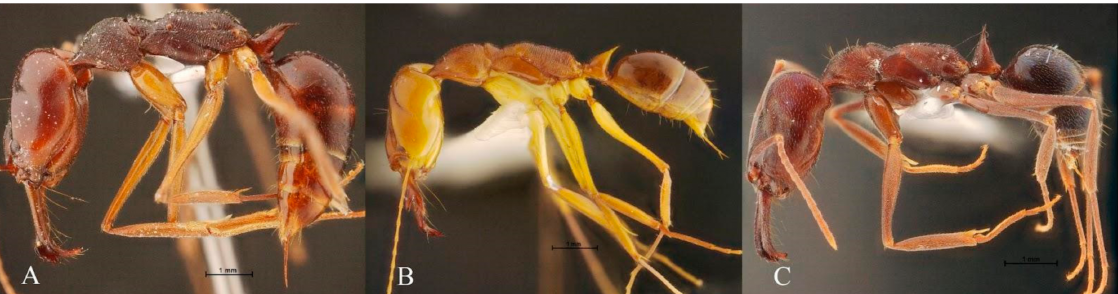
Figure 1. Morphology of workers Odontomachus monticola ( A ), O. rixosus ( B ), and O. simillimus ( C ).